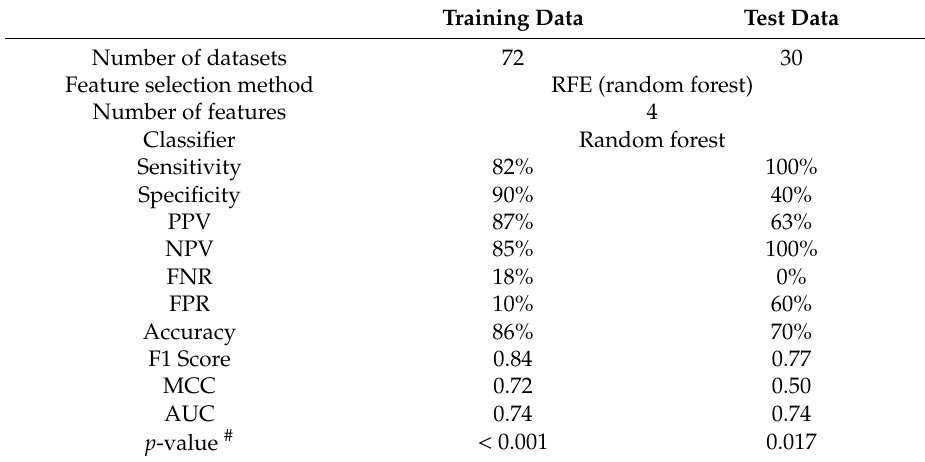
Table 4. Classification results of the machine learning model for di ff erentiating pseudoprogression from early tumor